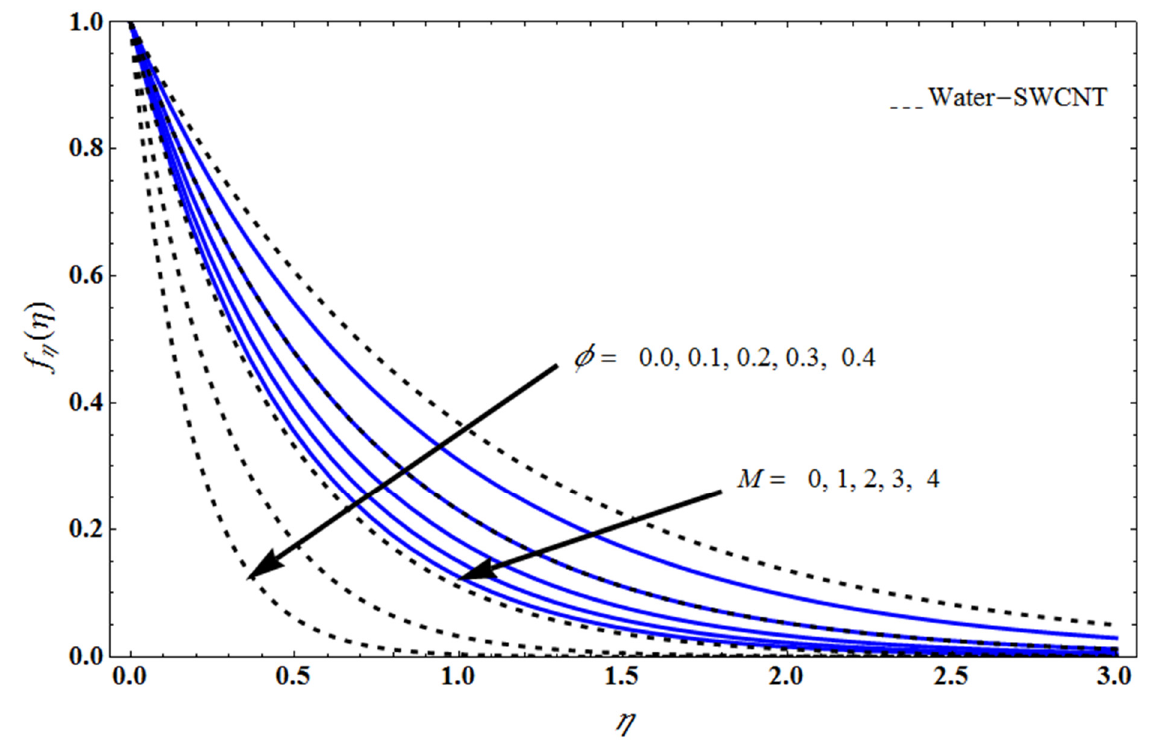
( ) η η f on for several values of η η ( η ) on η for several values of M , and φ , respectively.